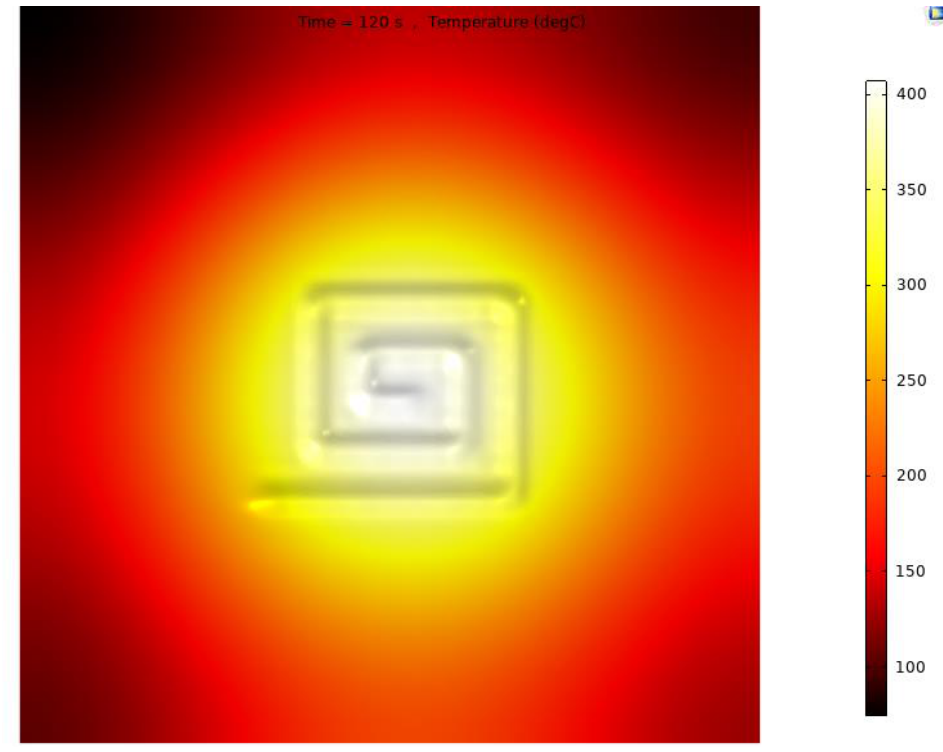
Figure 7. Distribution of temperature (in °C) after 120 s (track is finished and system is cooled).